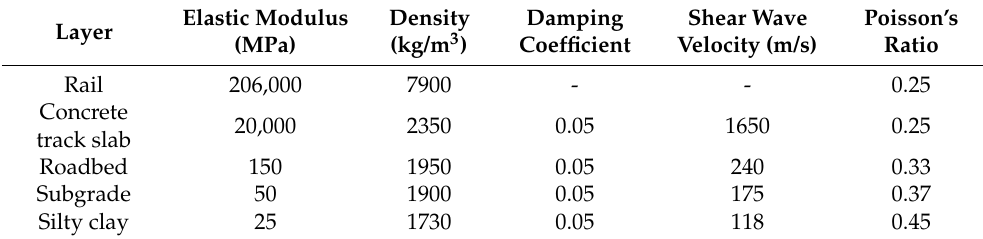
Figure 2. Dimensions of the railway structure: ( a ) point; ( b ) path. Table 1. Parameters of the railway